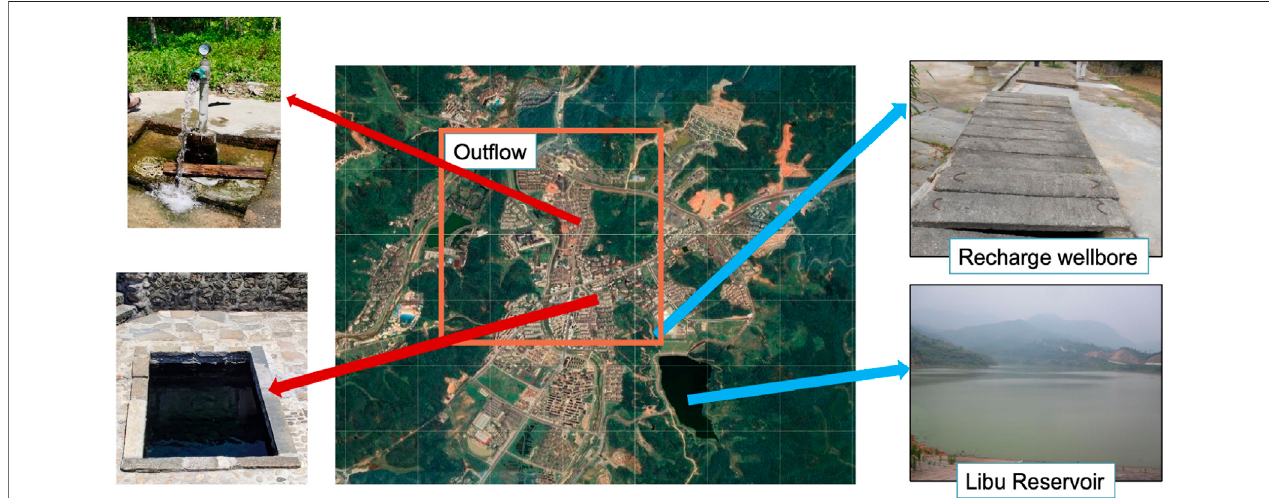
FIGURE 4 | Recharge (the blue arrow line) and out fl ow (the orange square area and typical representative listed by the red arrow line) area of the Wentang geothermal fi eld.